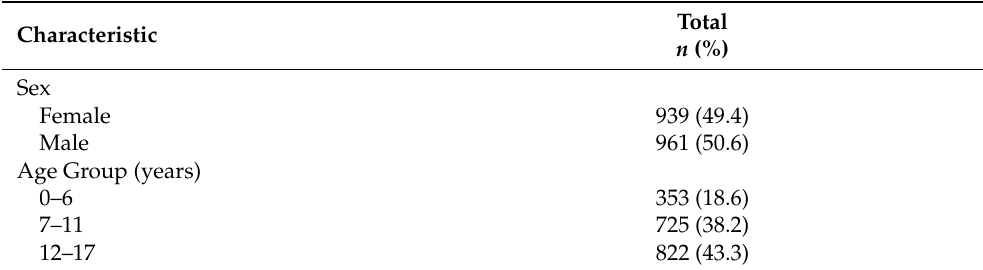
Table 1. Demographic characteristics of patients with sleep bruxism (SB). The total number of subjects analyzed was 1900. n, number of subjects in the